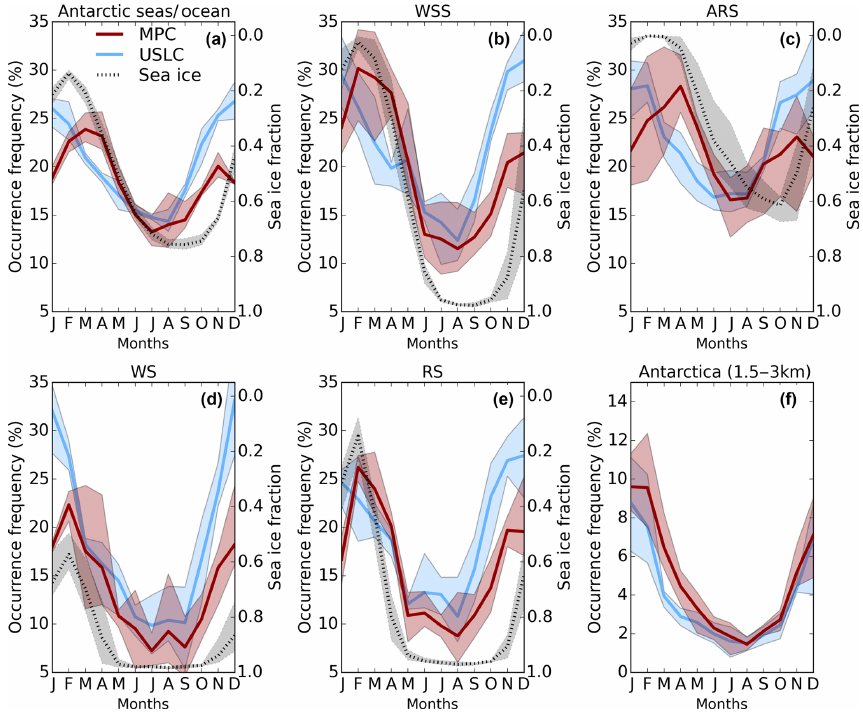
Figure 17. Four-year (2007–2010) average monthly time series of the low-level MPC fraction (black line) and the low-level USLC fraction (blue line), for the whole Antarctic waters (a) and for Antarctica (f) for surface heights between 1.5km and 3kma.s.l., as well as for the marine regions defined in Fig. 4b–e˙In each plot, the monthly time series of the sea ice fraction (dotted line, labelled on the right y axis that is flipped) is also plotted when relevant. The shaded areas indicate the amplitude of variation between the maximum and the minimum monthly averaged fractions recorded over